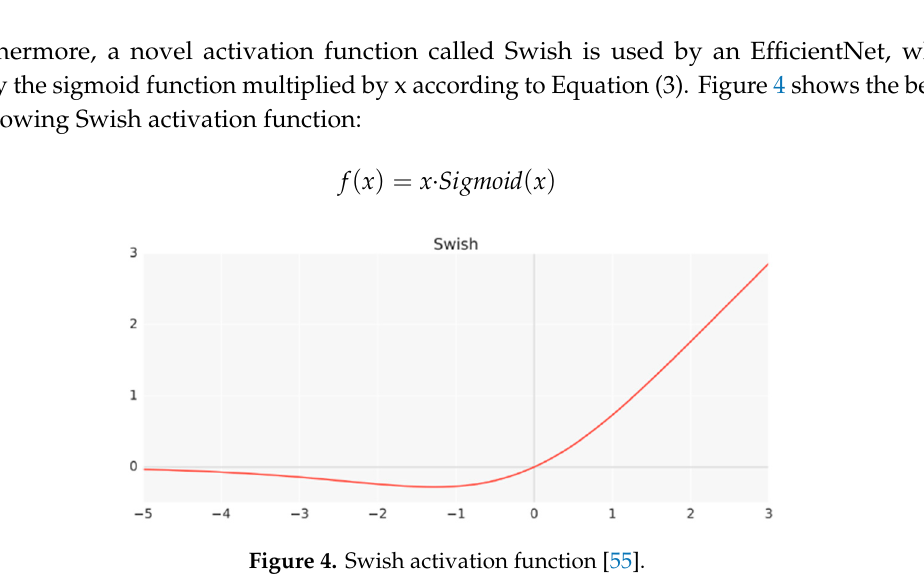
Figure 3. Flowchart of a fingerprint branch.